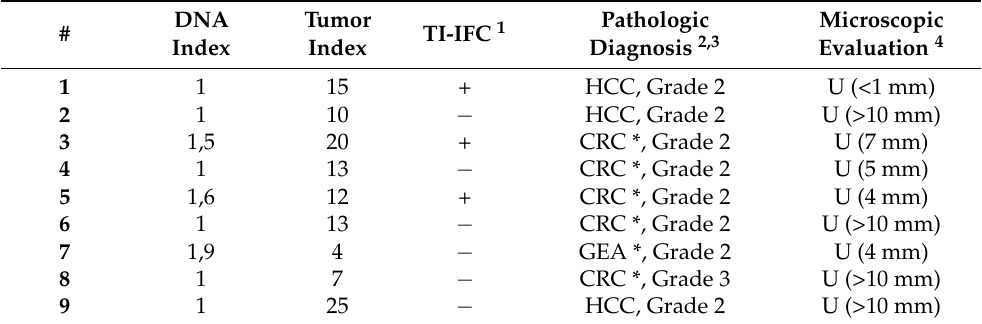
Table 1. Results from iFC and pathologic evaluation in resected primary and metastatic liver noeplasms. Pathologic Microscopic DNA Tumor # TI-IFC 1 Diagnosis 2,3 Evaluation 4 Index Index 1 1 15 + HCC, Grade 2 U (<1 mm) 2 1 10 − HCC, Grade 2 U (>10 mm) 3 1,5 20 + CRC *, Grade 2 1,6 12 1 13 − CRC *, Grade 2 U (>10 mm) 7 1,9 4